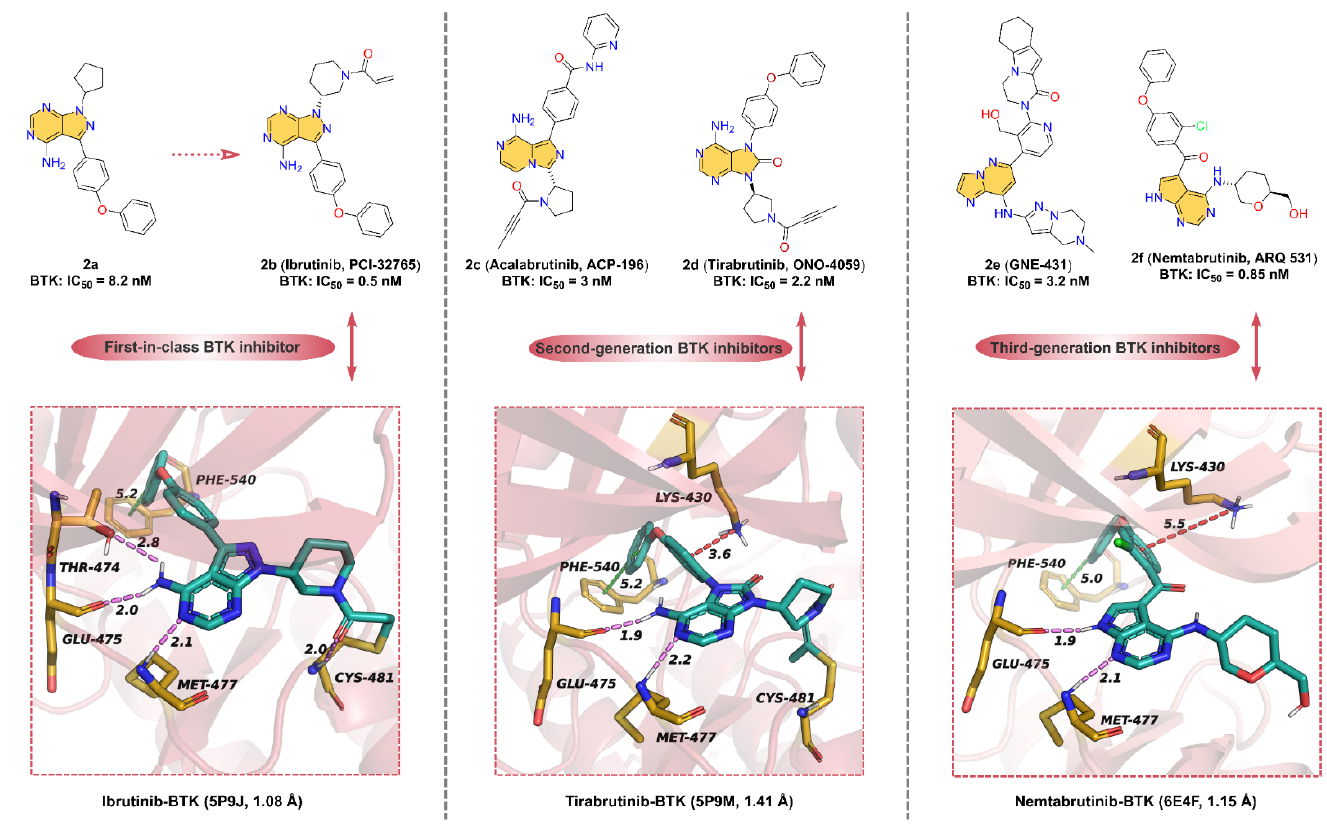
Figure 2. Representative azaindole/oxindole core-containing BTK inhibitor in clinical applications ( 2e, GNE-431 , has not yet entered into clinical studies).